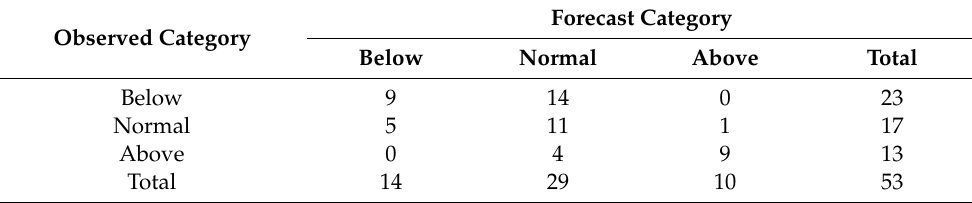
Table 7. Contingency table of the comparison between the forecasts and observations in June.